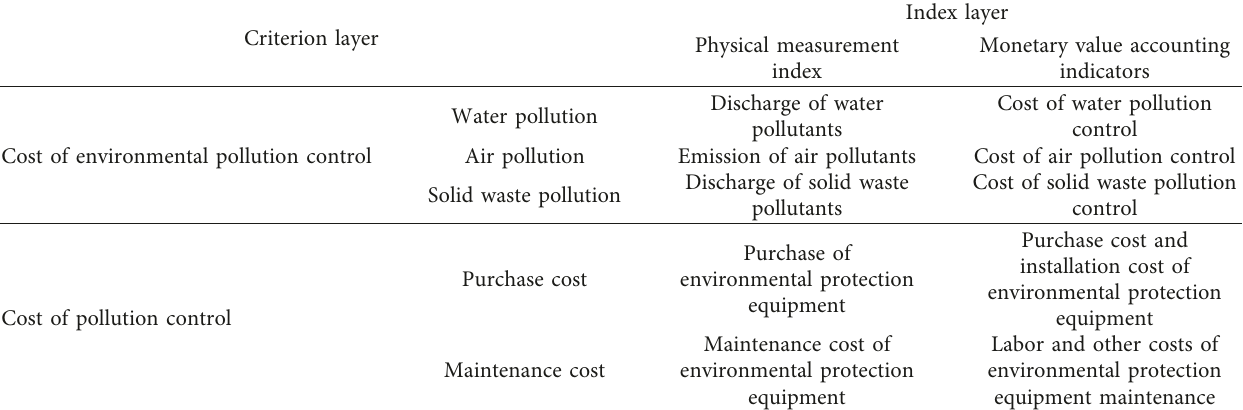
Table 1: Cost accounting index